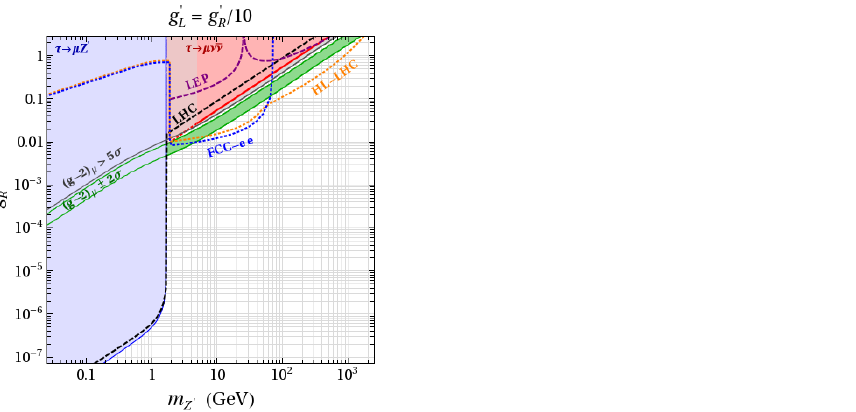
Figure 13. Prospect of m Z (cid:48) and g (cid:48) at HL-LHC (dotted orange line) and FCC-ee (dotted blue line) R = g (cid:48) with g (cid:48) /10. The green band corresponds the muon g − 2 anomaly at the 2 σ C.L. The blue, L R